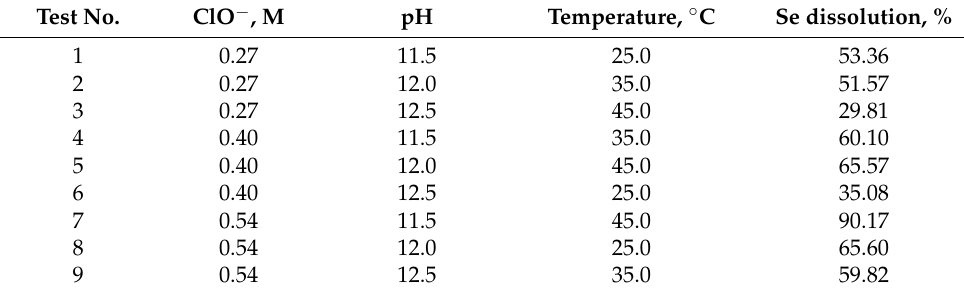
Table 5. Response to the Taguchi experimental model.